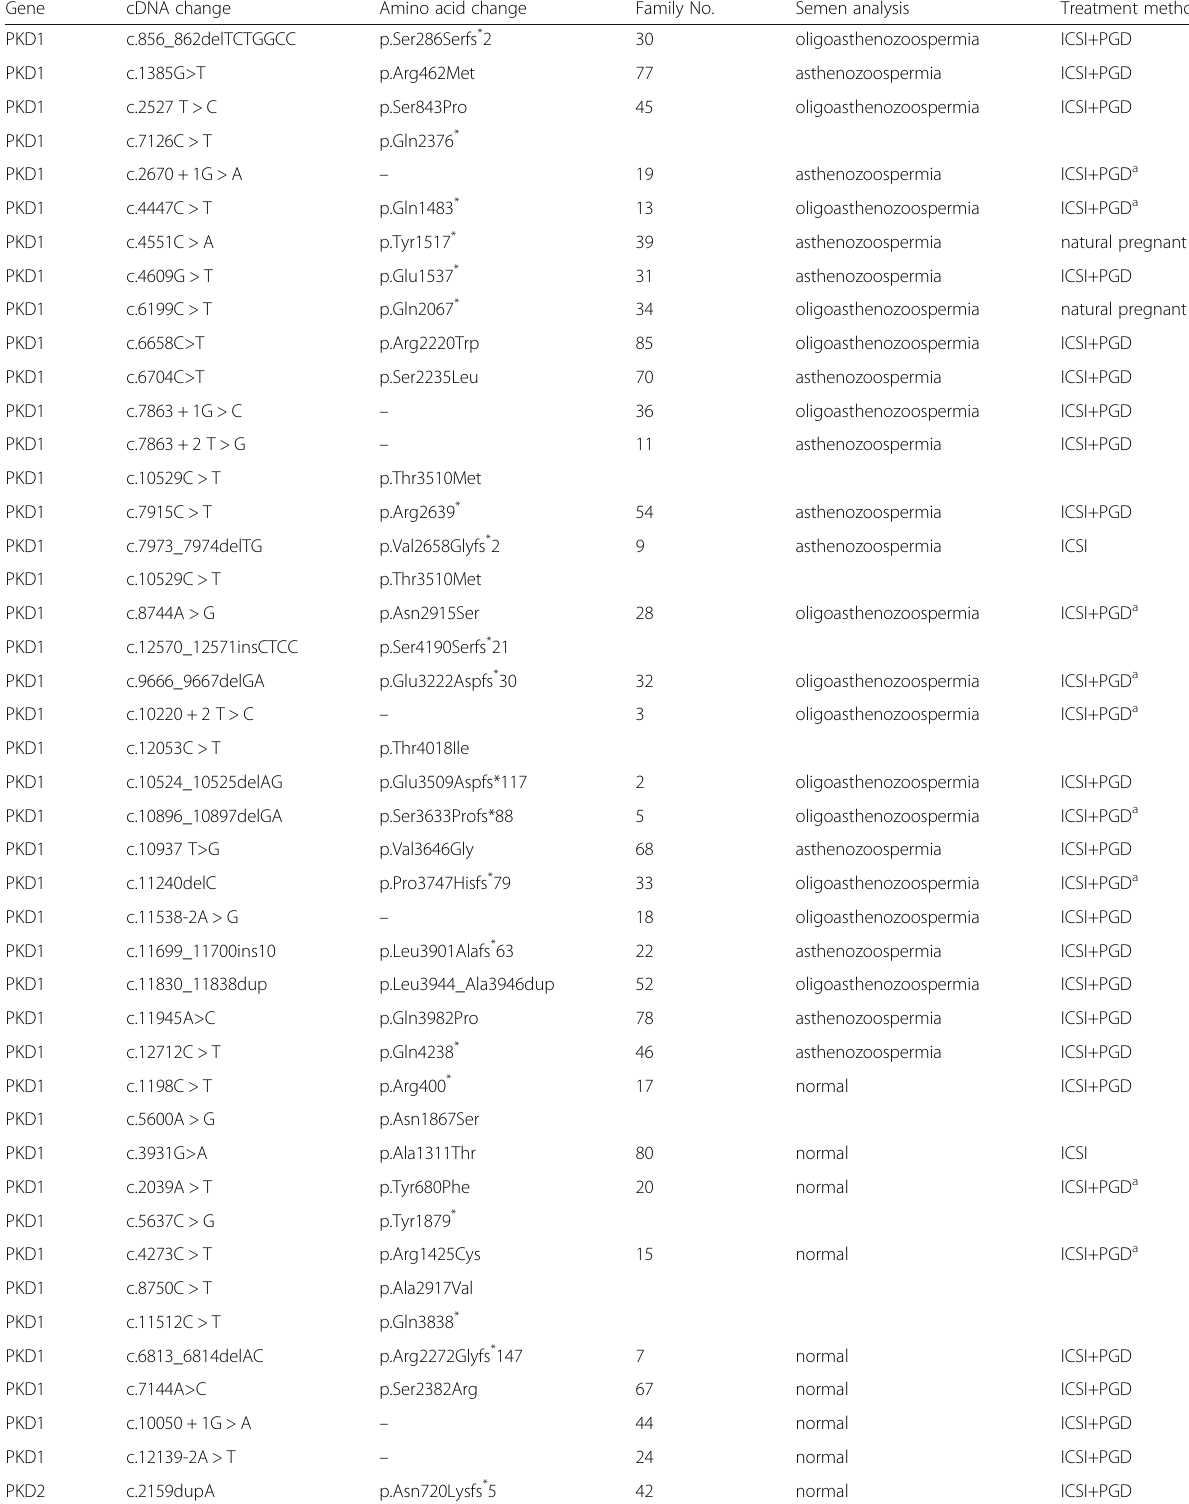
Table 4 The assisted reproductive therapies used by the 35 male patients and the clinical outcomes of those therapies Gene cDNA change Amino acid